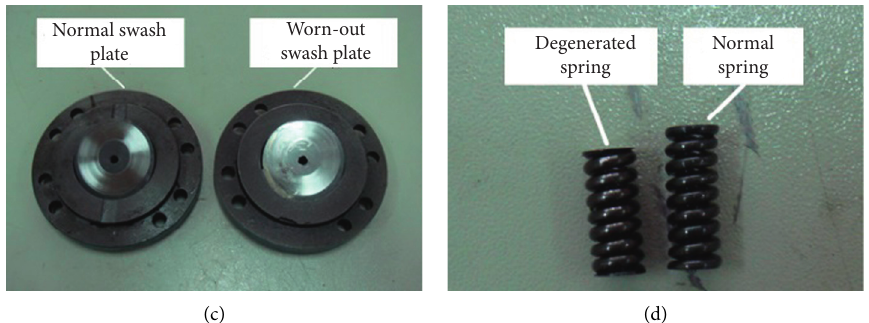
Figure 8: Schematic map of fault injection for axial piston pump. (a) Single slipper wear. (b) Single loose slipper. (c) Swash plate wear. (d) Center spring wear.